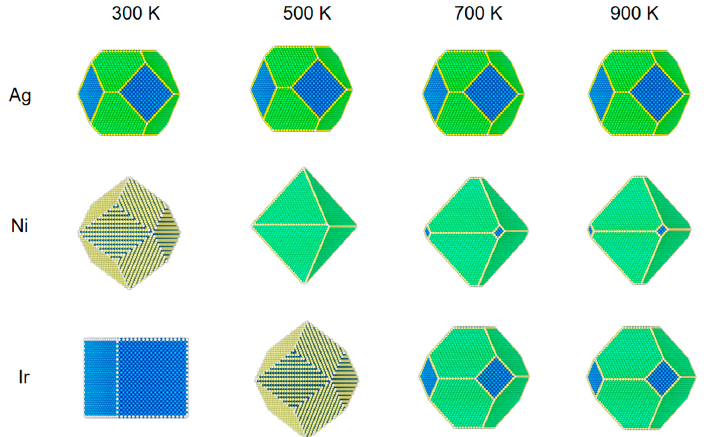
Figure 1. The structural evolution of 5 nm metal NPs (Ag, Ni, and Ir) at different temperatures and 1 Pa of CO. Blue is 100 surfaces, yellow is 110 surfaces, and green is 111 surfaces.